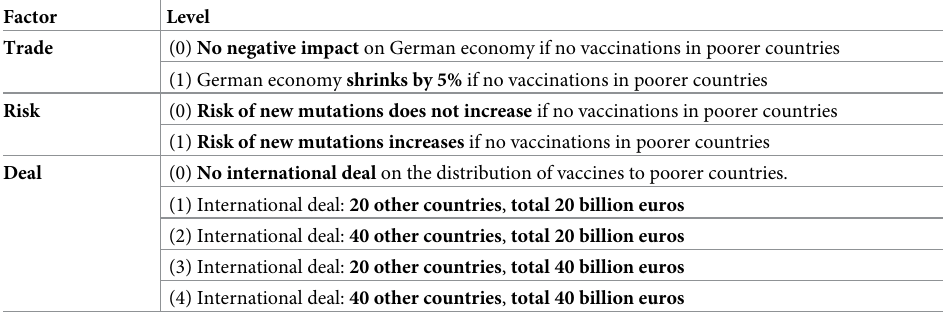
Table 2. Experimental design: Factors and